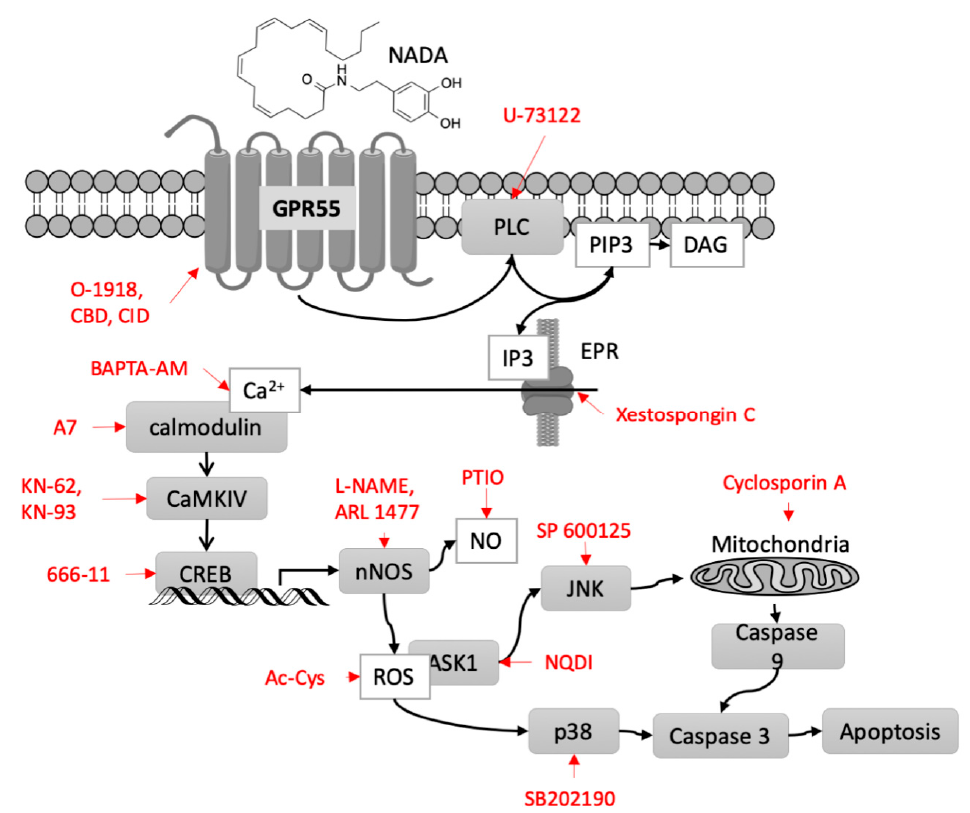
Figure 8. Proposed signal transduction during the cell death induction by endovanilloid DHA-DA. Inhibitors used in the work are shown in red. nNOS, neuronal NO synthase, JNK, c-Jun N-terminal kinase, ASK1, Apoptosis signal-regulating kinase 1, CBD, cannabidiol, CREB, cAMP response element-binding protein, EPR, endoplasmic reticulum, PIP3, Phosphatidylinositol (3,4,5)-trisphosphate, DAG, diacylglycerol, PLC, phospholipase C, IP3, Inositol trisphosphate, CaMKIV, Calcium/calmodulin-dependent protein kinase type IV, NADA, N-acyl dopamines.